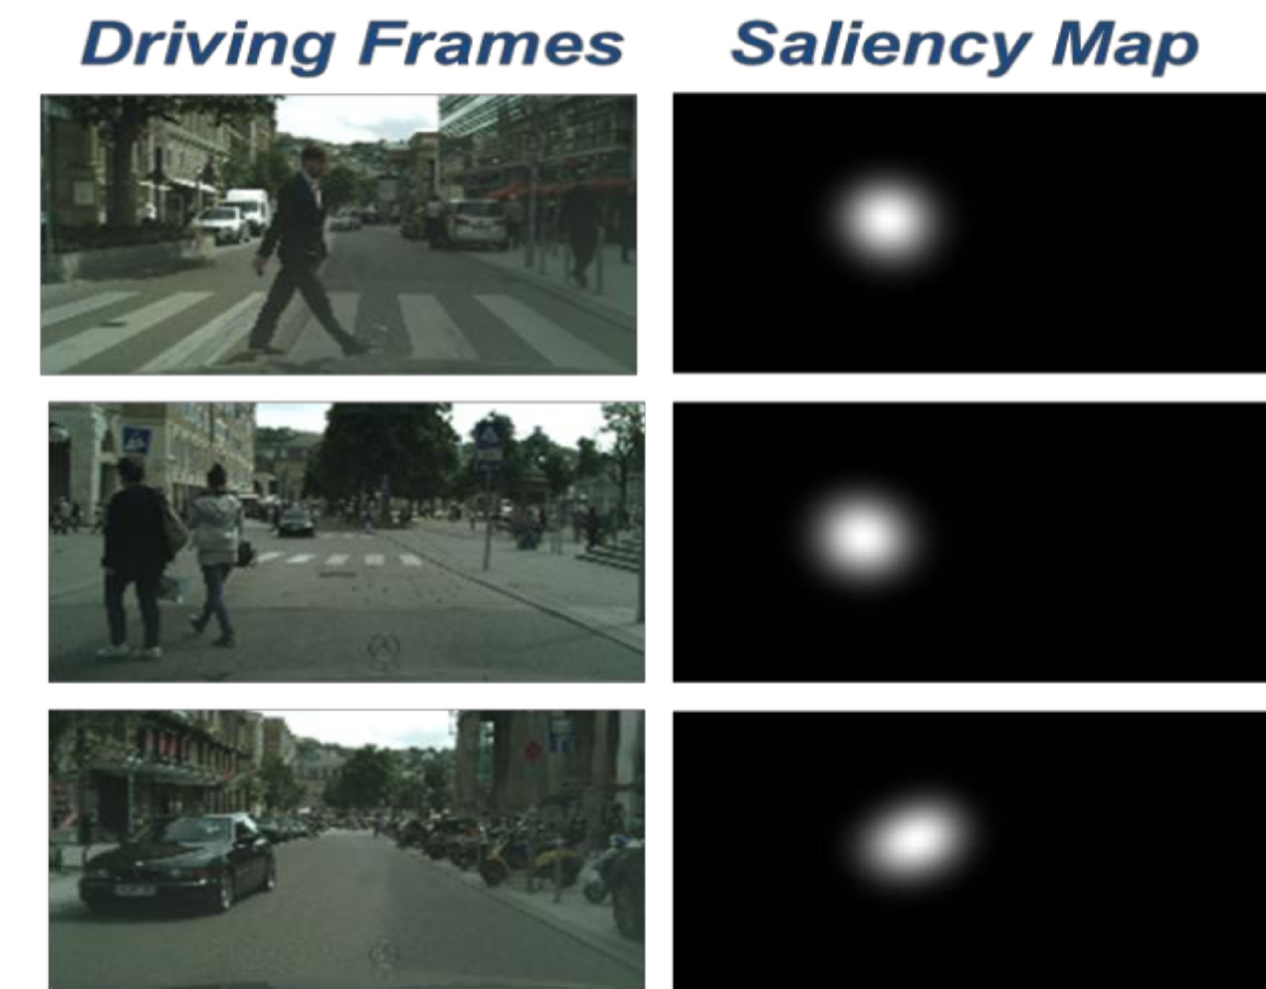
Figure 3. Saliency analysis of the video representing the driving scene. The bounding-box block will define the bounding area around the saliency map by means of an enhanced minimum rectangular box criteria (increased by 20% along each dimension) which is able to enclose the salience area. The following Figure 4 shows an example of an automatically generated bounding-box (red